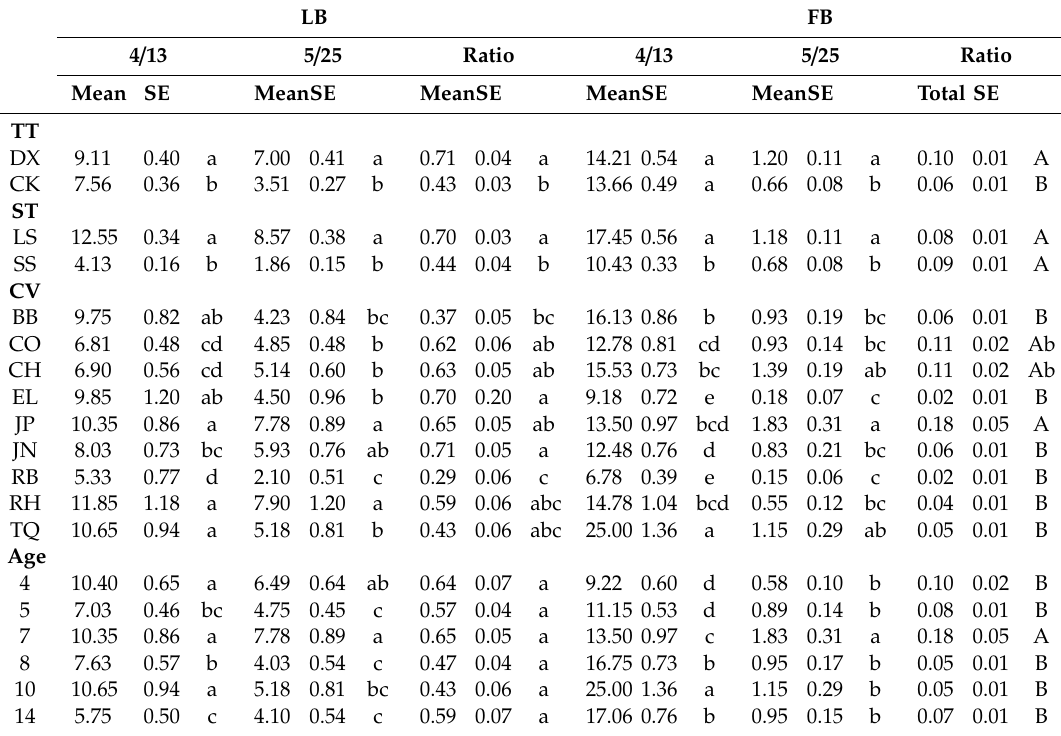
z Statistical output and F values indicating probability of significance were in Table S1. The counts of unopened lateral buds (LB) and flower buds (FB) (4 / 13) were done on 4 / 13 / 2017 prior to treatment. The count of breaking